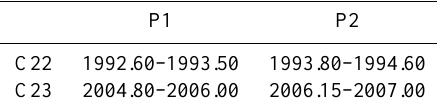
Table 1. Definition of time periods used in this study.